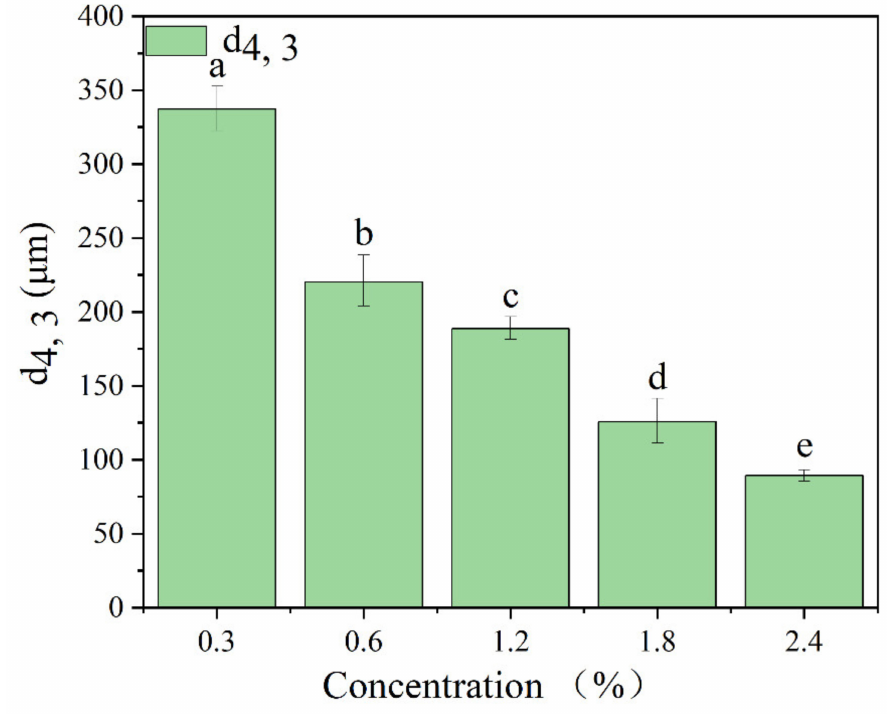
Figure 3. Volume mean diameter (d4, 3) of Pickering emulsions stabilized by different concentrations of TSCPN. Different lowercase letters indicated significant differences ( p < 0.05).